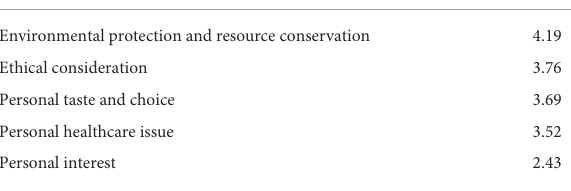
TABLE 8 Perceived benefits sorted by